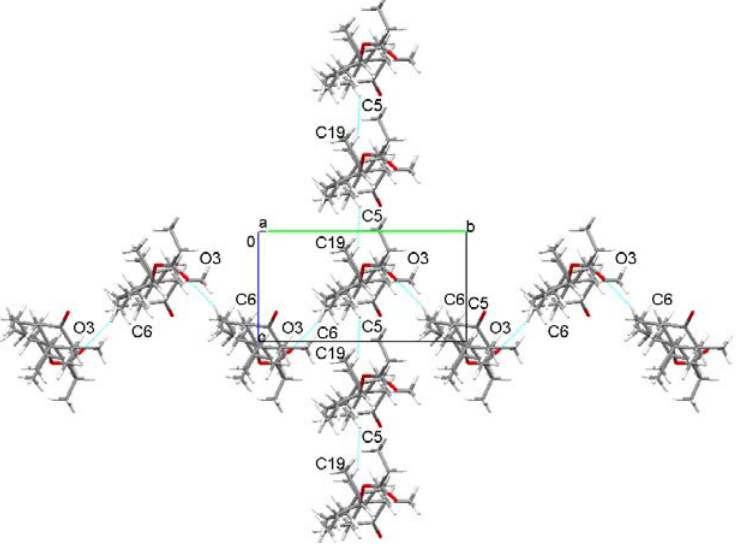
Figure 3. Packing diagram of Drost 1 showing the molecular chains in ob and oc directions.